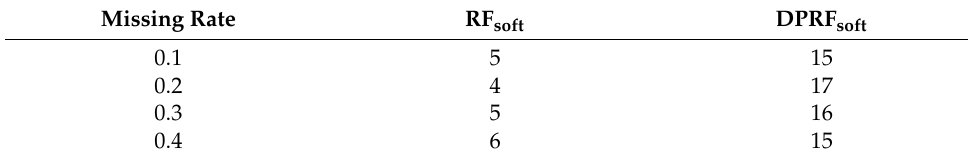
Table 6. Summary of LACC of RF and DPRF based on soft voting rules. Missing